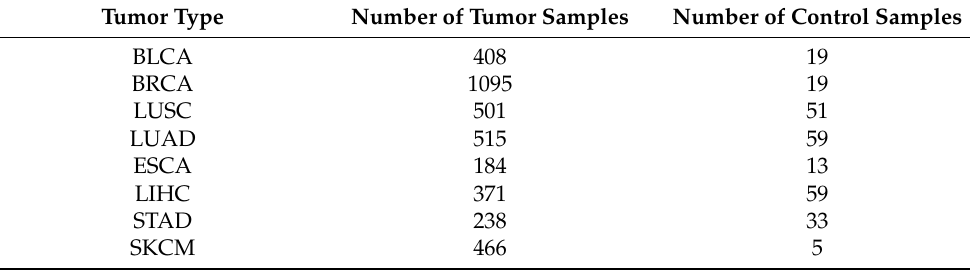
Table 1. Number of tumor samples and control samples in each tumor type.